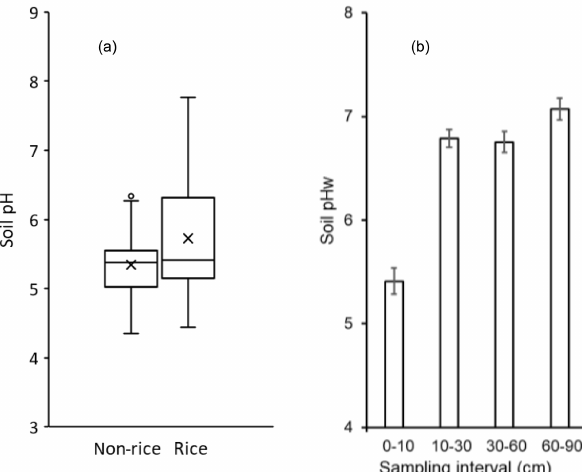
Figure 2. Soil pH w in (a) surface soil across seven EIP watersheds and (b) the mean of 54 rice field soil profiles at the Purulia district (bars are standard errors of